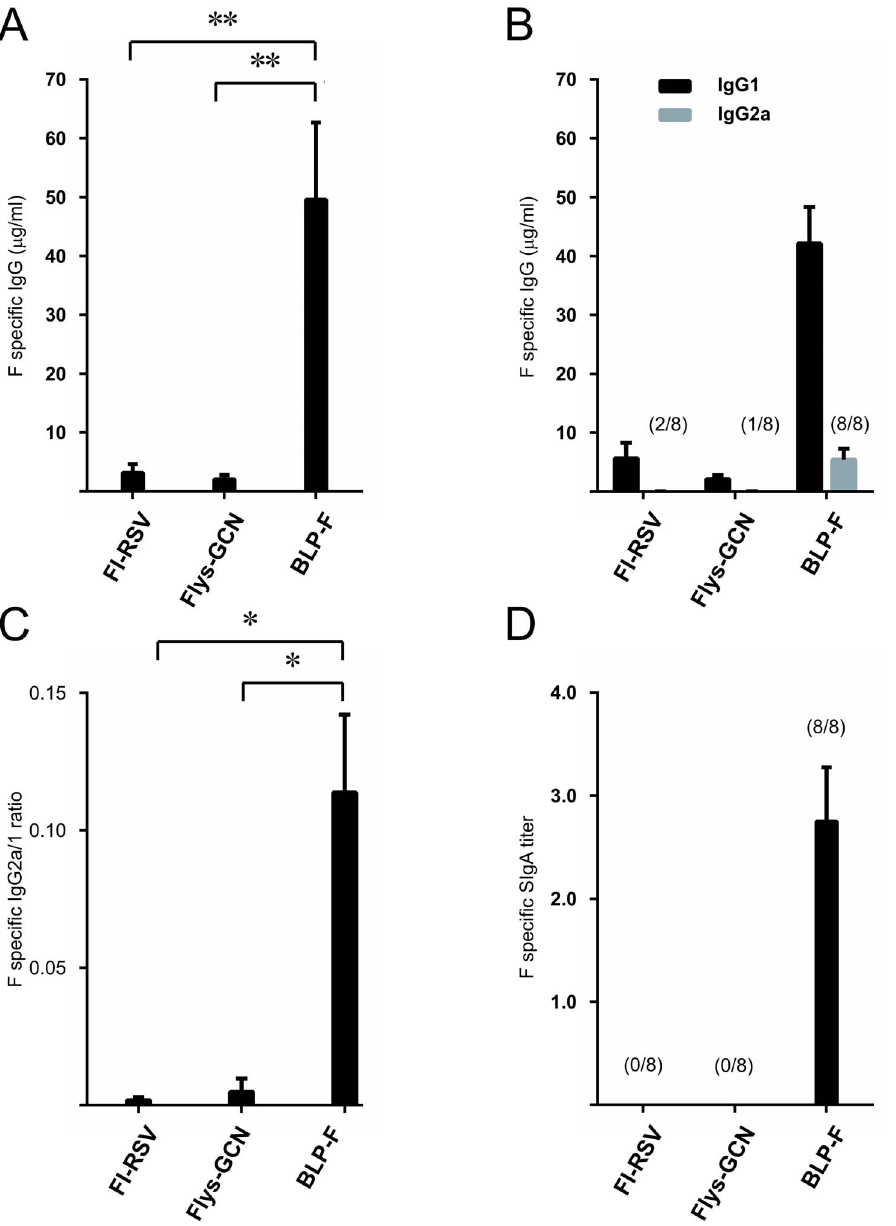
Figure 6. Immunization studies. Mice were immunized three times either intranasally with BLP-F or with unadjuvanted Flys-GCN4, or intramuscularly with FI-RSV with 14 day intervals. Samples were taken 28 days after the last vaccination. A) RSV-F specific IgG titers. B) RSV-F specific IgG1 and IgG2a titers. C) ratio of RSV-F specific IgG2a and IgG1 titers. D) RSV-F specific SIgA titers in the nose. Standard error of the mean (SEM) is indicated by the error bars. Numbers above the bars indicate the number of responders per group (* P # 0.05; ** P # 0.01 in Mann-Whitney U test). the RSV F protein is intrinsically more unstable than that of other class I fusion proteins.